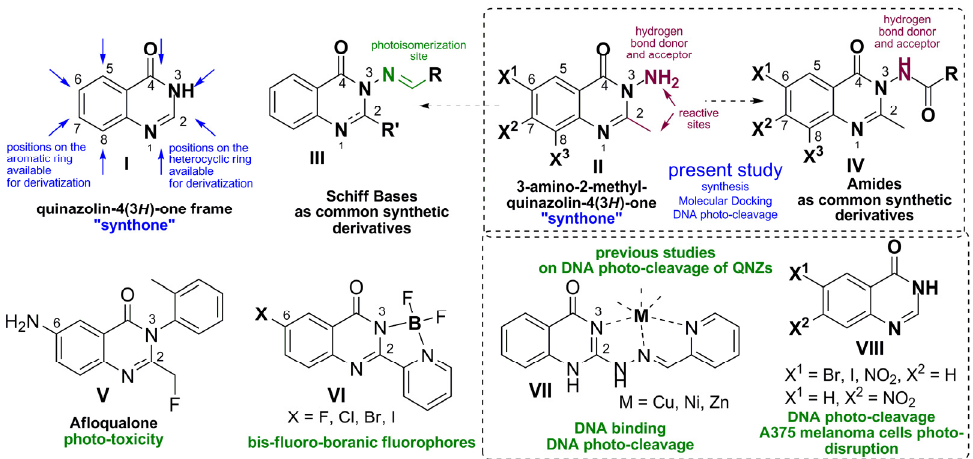
Figure 1. Structures of quinazolin-4(3 H )-one and 3-amino-2-methyl quinazolin-4(3 H )-one as synthones ( I and II , respectively); Common general structures of synthetic compounds derived from the amine functionality ( III and IV , respectively); Compounds found in the literature to show photoisomerization ( III ), phototoxicity ( V ), fluorescence activity ( VI ) and DNA photo-cleavage ( VII , VIII ).